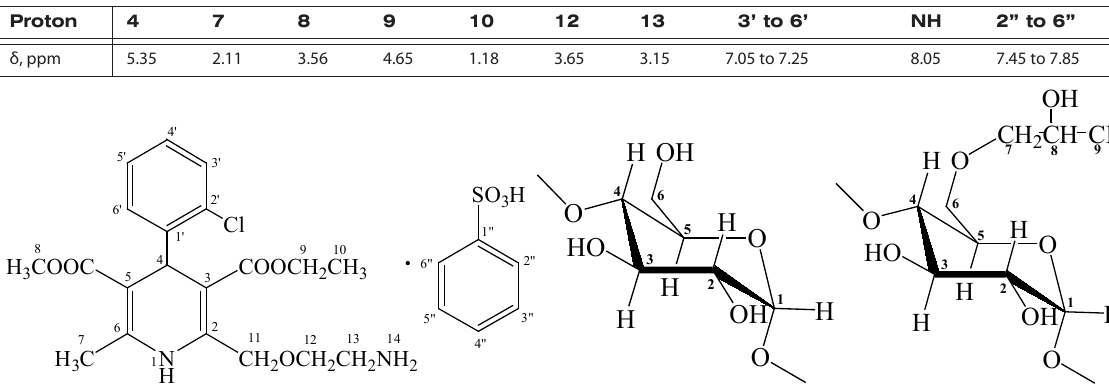
Table 1. Chemical shifts  in 1 H-NMR spectrum of amlodipine